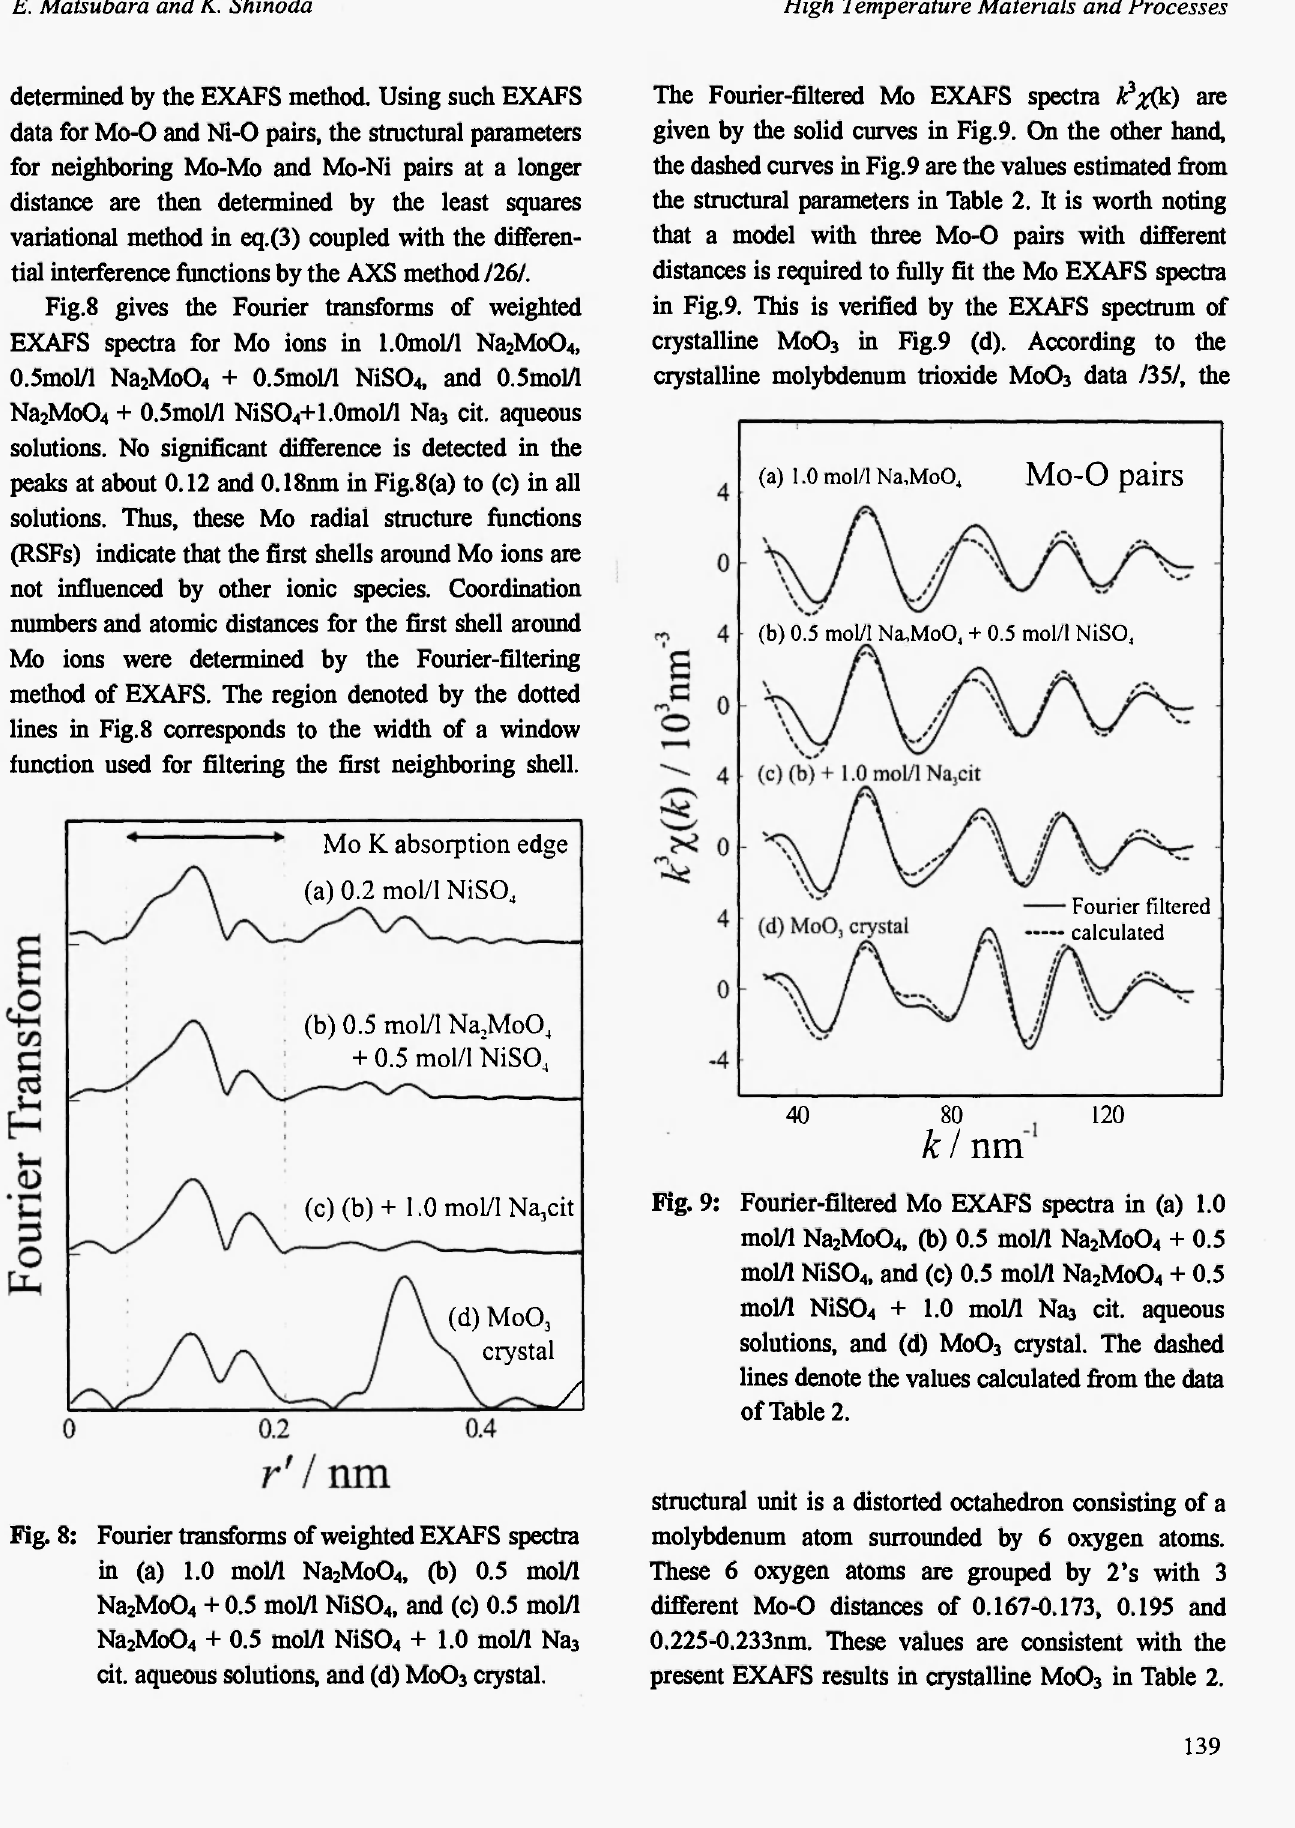
Mo0 , (b) 0.5 mol/1 2 4 , and (c) 0.5 mol/1 4 + 1.0 mol/1 Na 4 3 crystal. 3